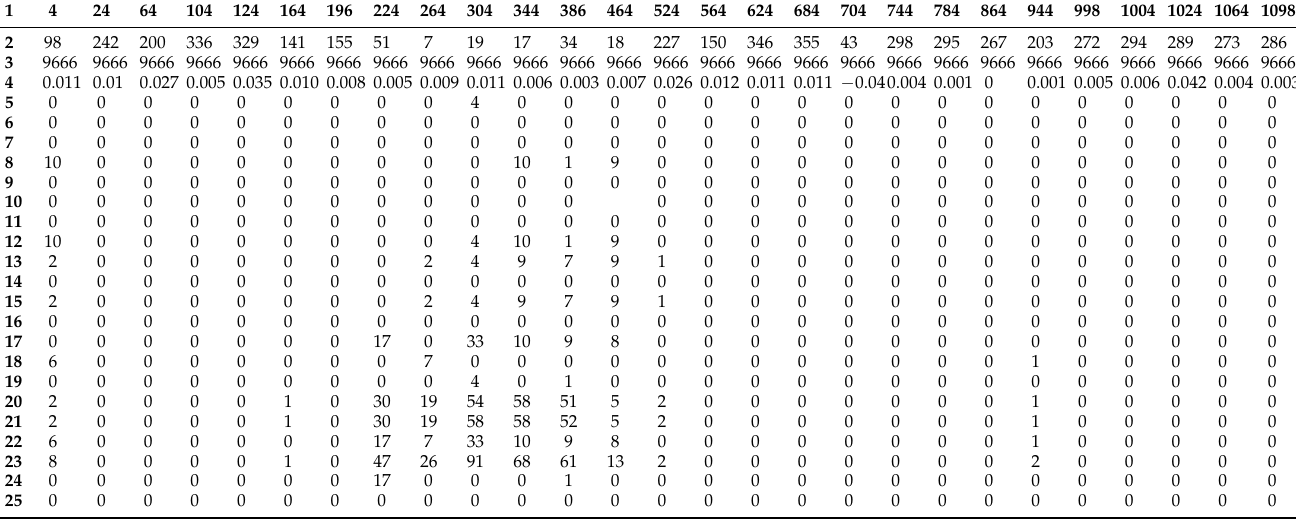
Table 6. Phytolith counts and calculated results. 1 depth (m), 2 Lycopodium counts, 3 Lycopodium spike, 4 dry weight (1g +/ − ), 5 Trapeziform sinuate: Pooideae, 6 Rondel-keeled, 7 Rondel-angular keel: Phalaris , 8 Rondel > 15 microns, 9 Rondel: Bambosoideae, 10 Saddle-long: Bambusoideae, 11 Bilobate-scooped: Ehrhartoideae, 12 total C 3 , 13 Saddle: Chloridoideae, 14 Saddle-tall: Chloridoideae, 15 total Saddles: C 4 Xeric, 16 Saddle-plateau: Sporobolus -type, 17 Cross-3-lobed, 18 Cross, 19 Polylobate: Panicoideae, 20 Bilobate: Panicoideae, 21 total Bilobates, 22 total Crosses, 23 total C 4 Mesic, 24 Rondel < 15 microns, 25 Grass epidermis, 26 Bulliform, 27 Stomatal cell, 28 Dendriform, 29 total various grasses, 30 Trichome, 31 Elongate-psilate, 32 Elongate-echinate, 33 Blocky-grass/sedge